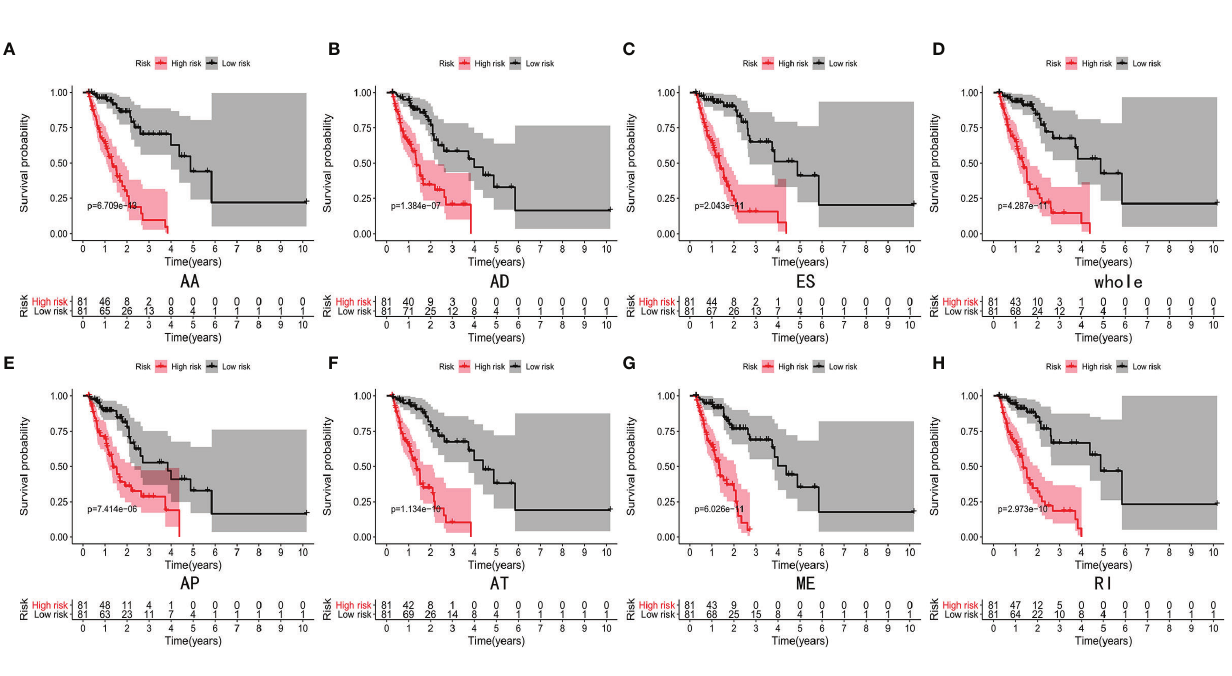
Furthermore, we analyzed the correlation between RBM25 and AS events, with parental genes as prognosis markers. Our results demonstrated that RBM25 ( Figure 9G ), SEC23A-27345-AP ( Figure 9J ), and ZNF638-53926-AP ( Figure 9L ) were all negatively related to the OS of EC patients. On the contrary, ( Figure 9M ) were positively related to the OS which was consistent with the regulation of expression level. However, the parental genes SEC24A ( Figure 9H ) and ZNF638 ( Figure 9I ) were not the prognosis predictors of EC. Both the expression and